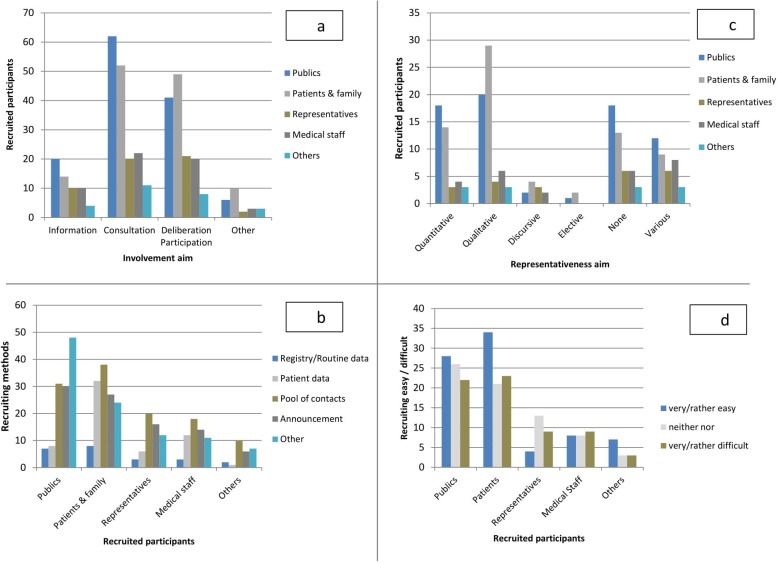
Summary of results.